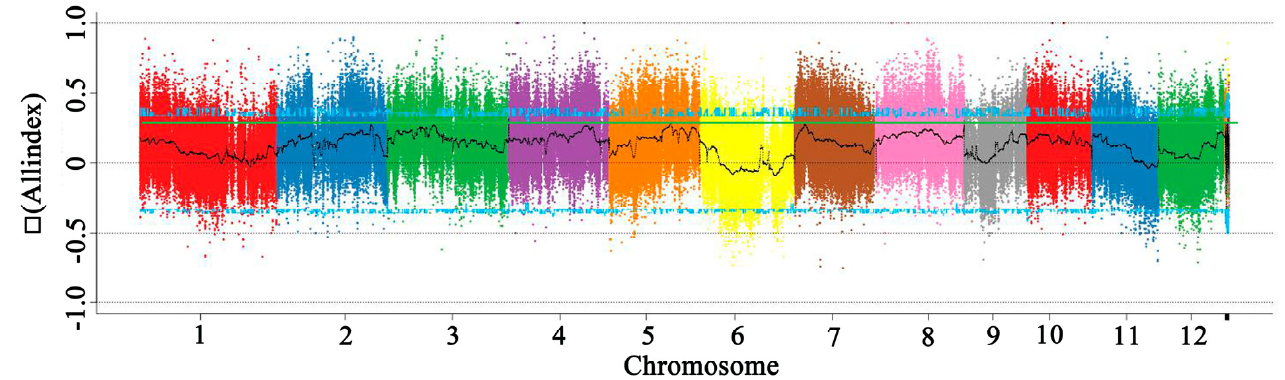
Figure 5. The Gene Ontology (GO) enrichment analysis of candidate regions.